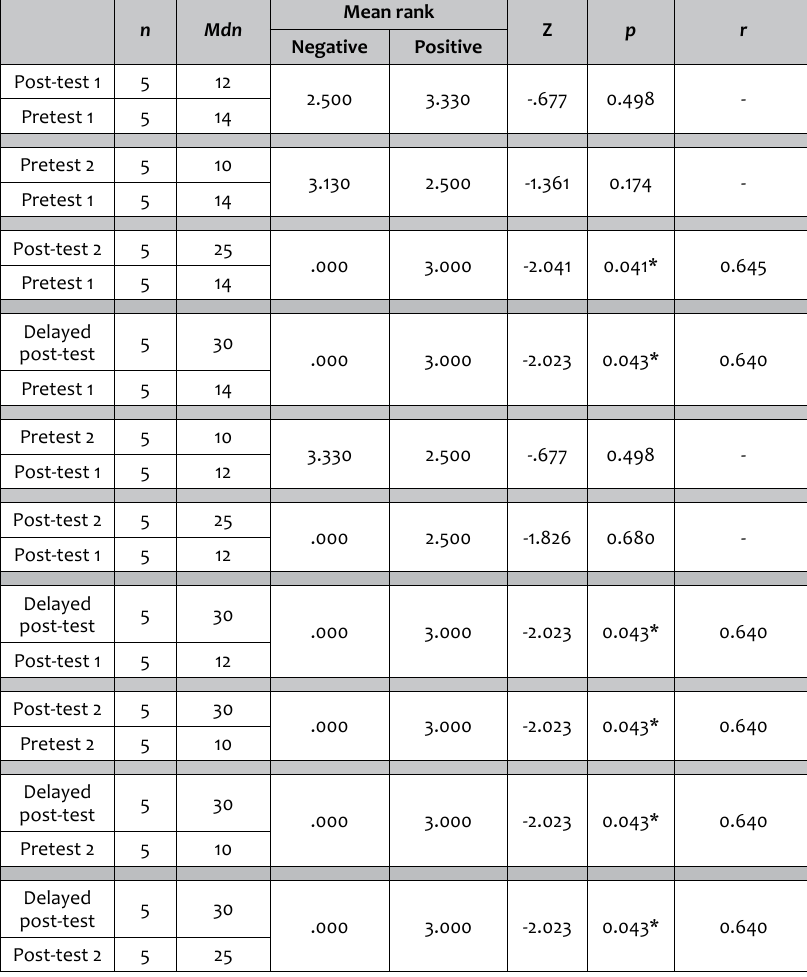
Table 3 below summarises the differences between pre- and post-test results within experimental group B. Table 3: Comparison of differences between test results within experimental group B n